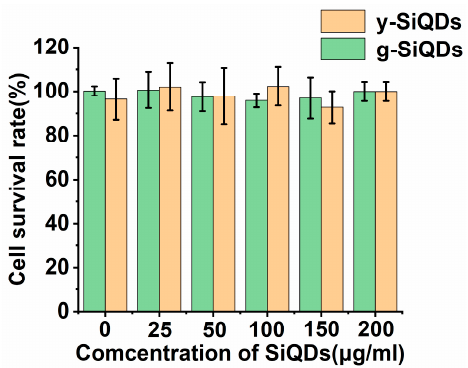
Figure 9. Cell viability (%) measured by MTT assay. The L02 cells were incubated with the SiQDs for 24 h at 37 °C. All results were presented as the mean ± standard deviation (SD) from three independent experiments with four wells in each.